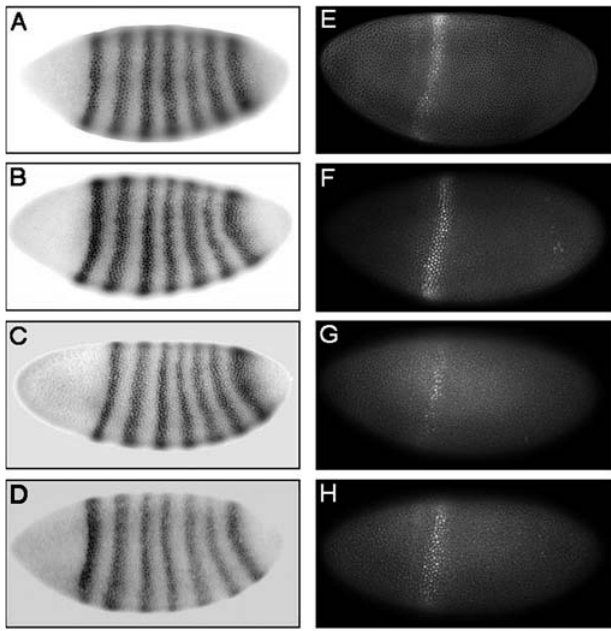
Figure 1. Expression of eve (A–D) Embryos of four Drosophila species at early cellular blastoderm stage. EVE stained with immunoperoxidase DAB reaction enhanced by nickel. (E–H) Df(eve) D. melanogaster embryos with two copies of transgenes containing eve S2E from four species fused to D. melanogaster eve coding region ( (cid:1) 0.9 to þ 1.85 kb) at blastoderm stage. Immunofluor- escence-labeled EVE. The S2E ere -EVE (G) produces consistently weaker stripes than lines carrying S2Es from the other three species. (A and E) D. melanogaster, (B and F) D. yakuba, (C and G) D. erecta, and (D and H) D. pseudoobscura. DOI: